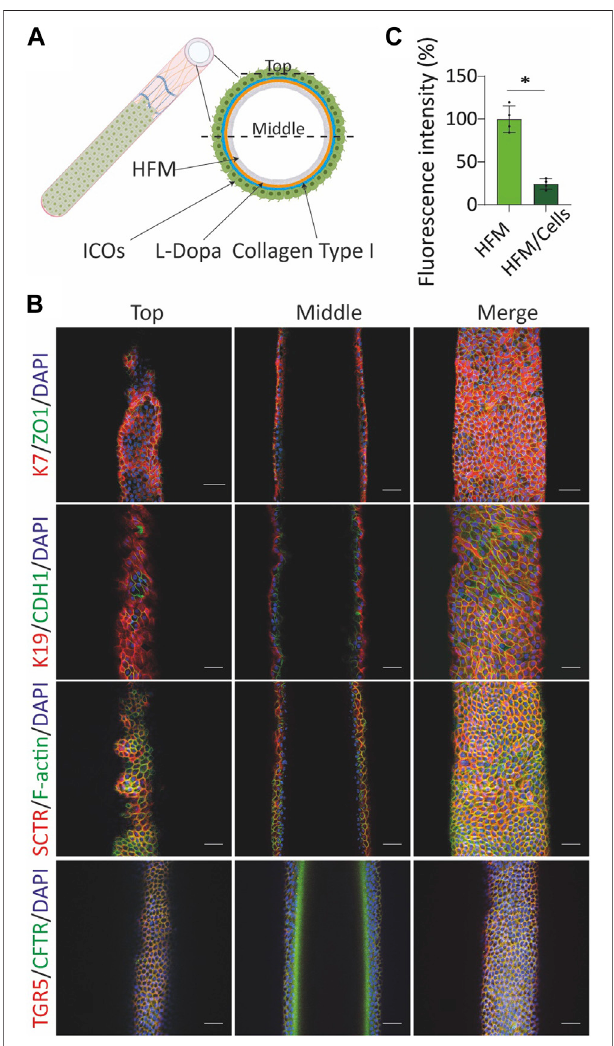
FIGURE4| Cultureofcholangiocyte-likecells(CLCs)ontheextracellular matrix (ECM)-coated hollow fi ber membrane (HFM) form tight and mature bile duct. (A) Illustrativeimage ofHFM-cultured CLCs. (B) Bioengineeredbileduct immunostaining. Immuno fl uorescence analysis ofthe bioengineered bile duct expression of key cholangiocyte markers [keratin (K) 7 and 19], transport markers [(secretin receptor (SCTR), G protein-coupled bile acid receptor 1 (GPBAR1, alsoknownasTGR5),cystic fi brosis transmembraneconductance regulator (CFTR)], F-actin, epithelial markers [cadherin 1 (CDH1), and tight junction protein 1 (ZO1)]. Scale bar = 50 μ m. (C) Trans-epithelial barrier function. Theinulin-FITC leakage wasassessed inthepresenceor absenceof CLCs; data are shown as mean ± SD of four independent experiments for each group. Statistical differences between groups were analyzed using the two-tailed Mann – Whitney U test; HFM, N = 4; HFM/Cells, N = 4; * p < 0.05.